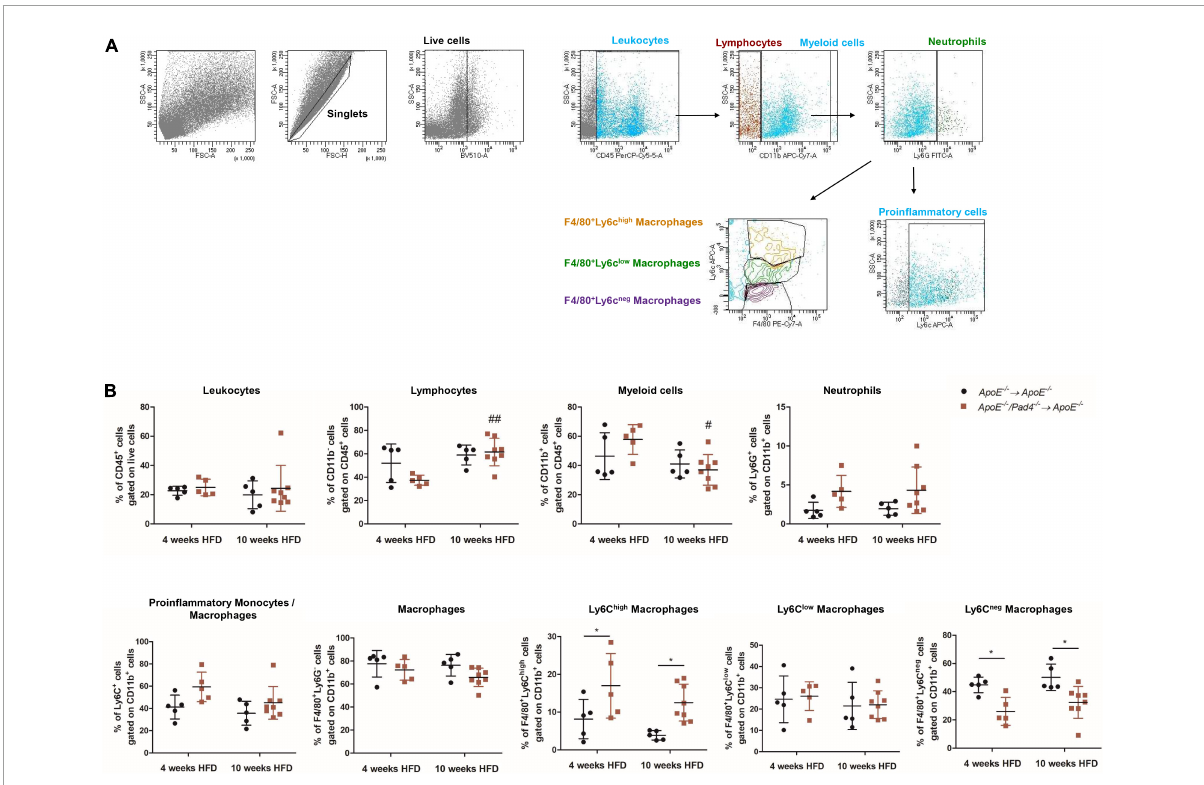
FIGURE5 PAD4 modulates macrophages’ phenotype in vivo . Aortas from mice were enzymatically digested and cells were stained with different fluorochrome-conjugated antibodies followed by flow cytometric analysis. (A) Representative plots illustrating the gating strategy to identify immune cell populations. (B) Quantification of leukocytes (CD45 + ), lymphocytes (CD45 + CD11b − ), myeloid cells (CD45 + CD11b + ), neutrophils (CD45 + CD11b + Ly6G + ), inflammatory monocytes/macrophages (CD45 + CD11b + Ly6G − Ly6C + ), macrophages (CD45 + CD11b + Ly6G − F4/80 + ) as well as M1-like (F4/80 + Ly6C high ) and M2-like (F4/80 + Ly6C low and F4/80 + Ly6C neg ) macrophages in digested aortas from mice after 4 and 10 weeks of high-fat diet (HFD). n = 5–8/group. # p < 0.05, ## p < 0.01 vs. 4 weeks HFD; * p <